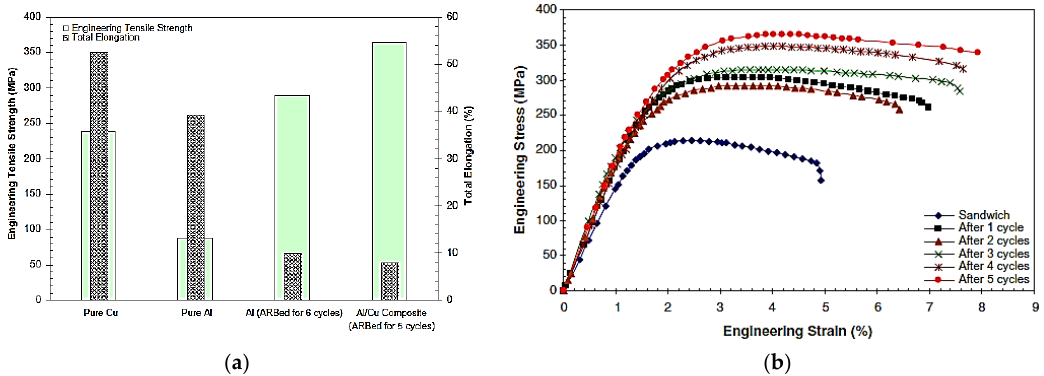
Figure 12. ( a ) Yield strength and total elongation of Cu, Al, ARBed Al, and ARB Al/Cu composite, ( b ) engineering stress–strain curves for ARBed Al/Cu composite with cycles [84].